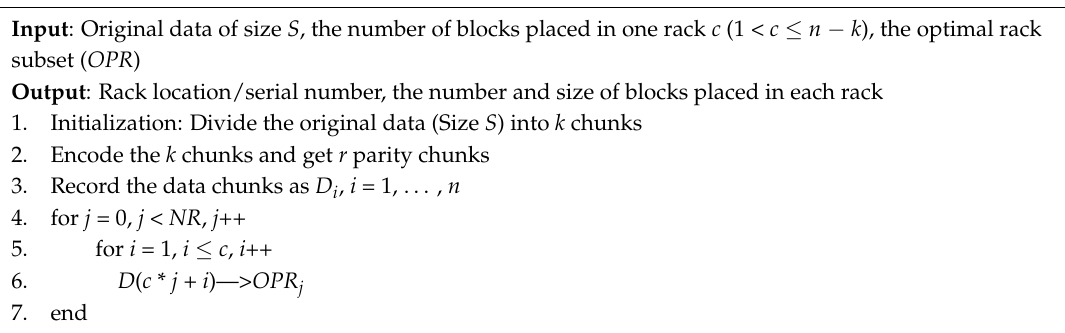
Algorithm 1 Algorithm for data placement